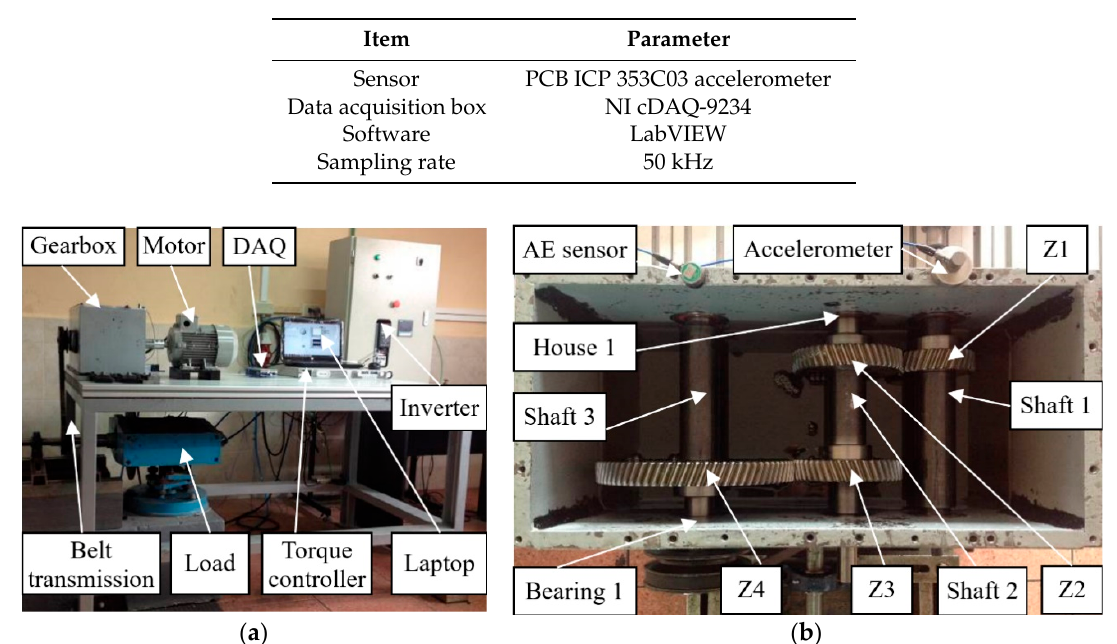
Figure 6. ( a ) Experimental test rig and ( b ) the structure of the gearbox.